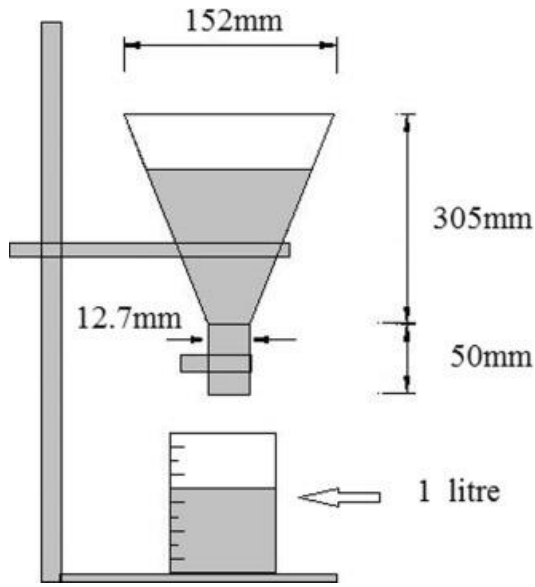
Figure 1 . Modified Marsh cone [11] . Table 5 . Classifications of foam concrete with respect to the flow time [11] . Table 5. Classifications of foam concrete with respect to the flow time